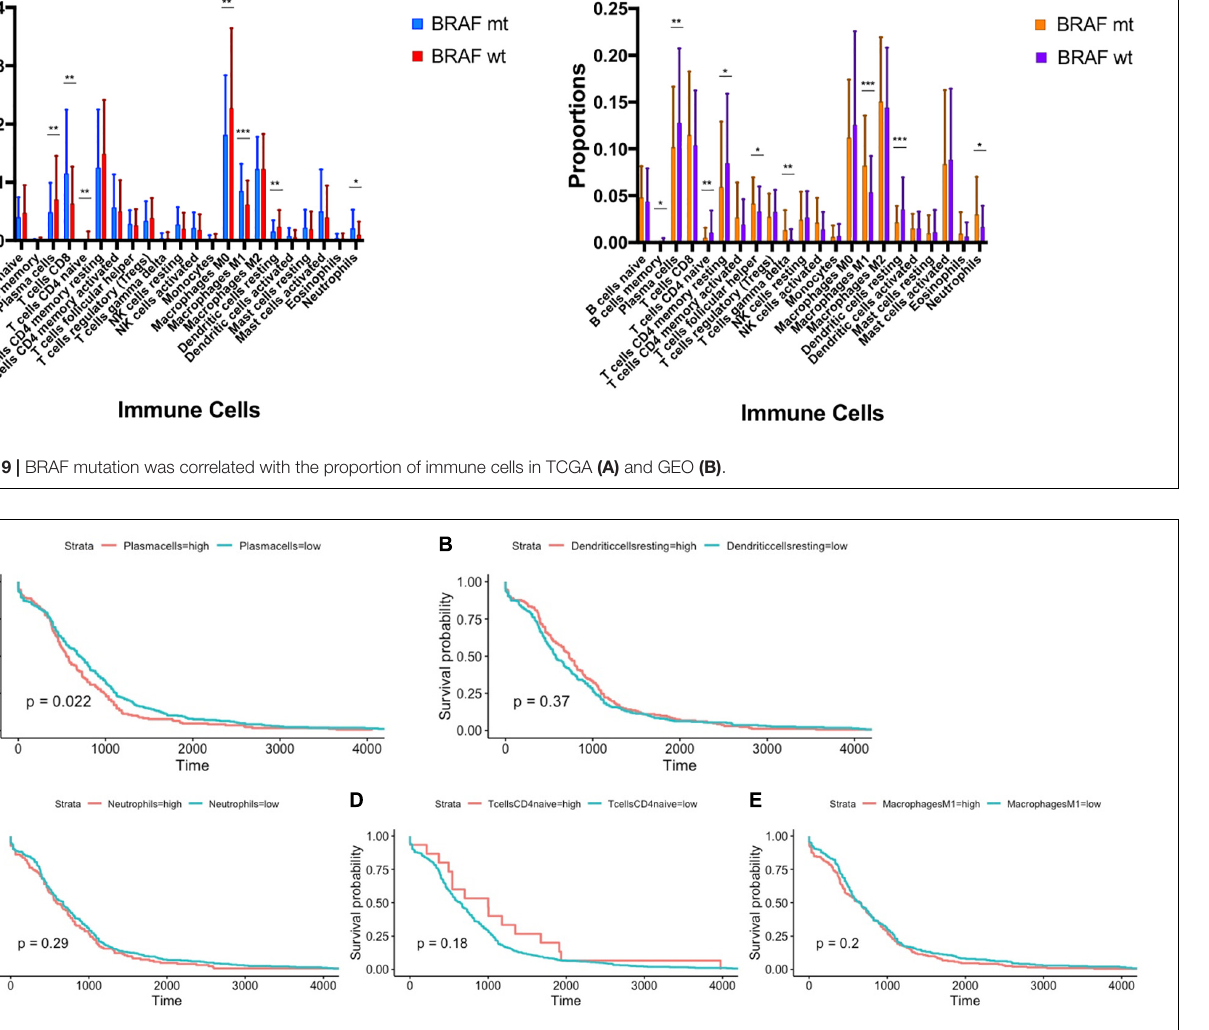
FIGURE 10 | BRAF mutation-related immune cells, including plasma cells (A) , dendritic cells resting (B) , neutrophils (C) , T cells CD4 naïve (D) , and macrophages M1 (E) and their association with overall survival. Log-rank test for Kaplan–Meier curves was conducted to assess the association between overall survival and expression